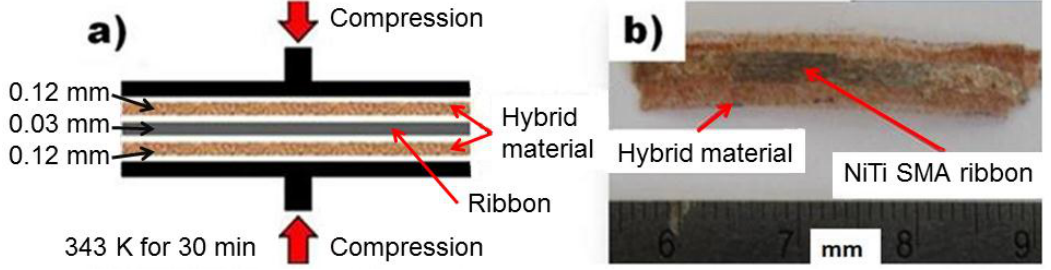
Figure 3. ( a ) Schema of the joining process of the magnetic hybrid film and the SMA ribbon (lateral view). ( b ) Smart composite